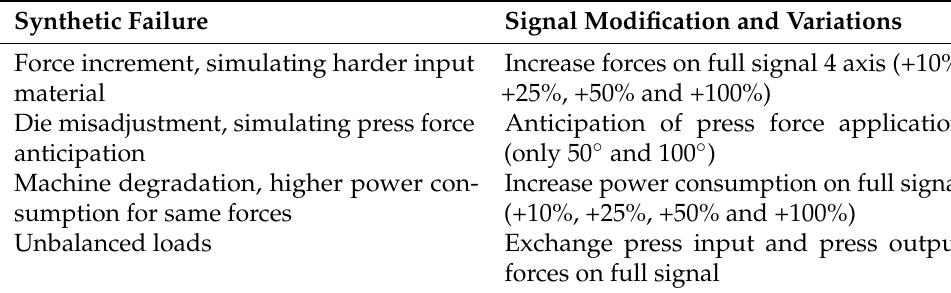
Table 1. Synthetic failures and corresponding signal modifications used for model